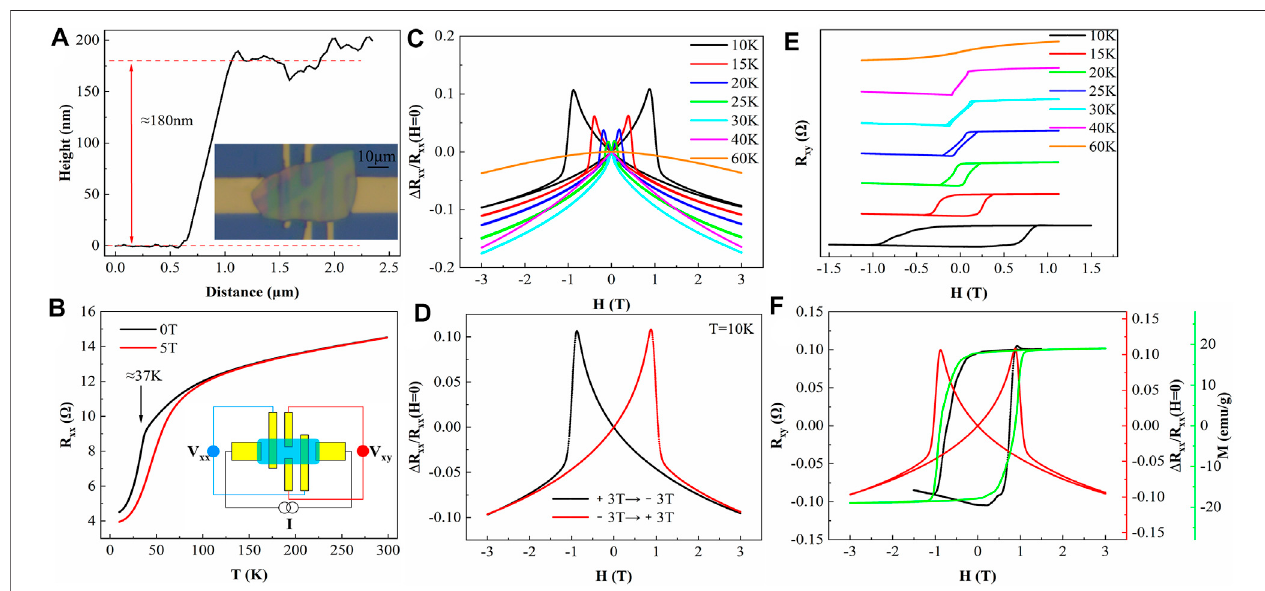
FIGURE2|(A) Pro fi lelineinformationextractedfromAFMimageontheedgeoftheFeTa 3 S 6 thin fi lm,andtheinsetshowstheopticalimageoftheFeTa 3 S 6 device. (B) Temperature-dependent resistance with zero fi eld and 5T magnetic fi eld, and the inset shows a schematic diagram of the device measurement con fi guration. (C) Magnetoresistancemeasured atselectedtemperature withapplied magnetic fi eldH (cid:3) c. (D) Magnetoresistance measured atT=10K withappliedmagnetic fi eldH (cid:3) c. (E) Hall resistance measured at selected temperature with applied magnetic fi eld H (cid:3) c. (F) Determine the switching fi eld of the FeTa 3 S 6 sample by R xy -H (black), MR (red), and M-H (green).